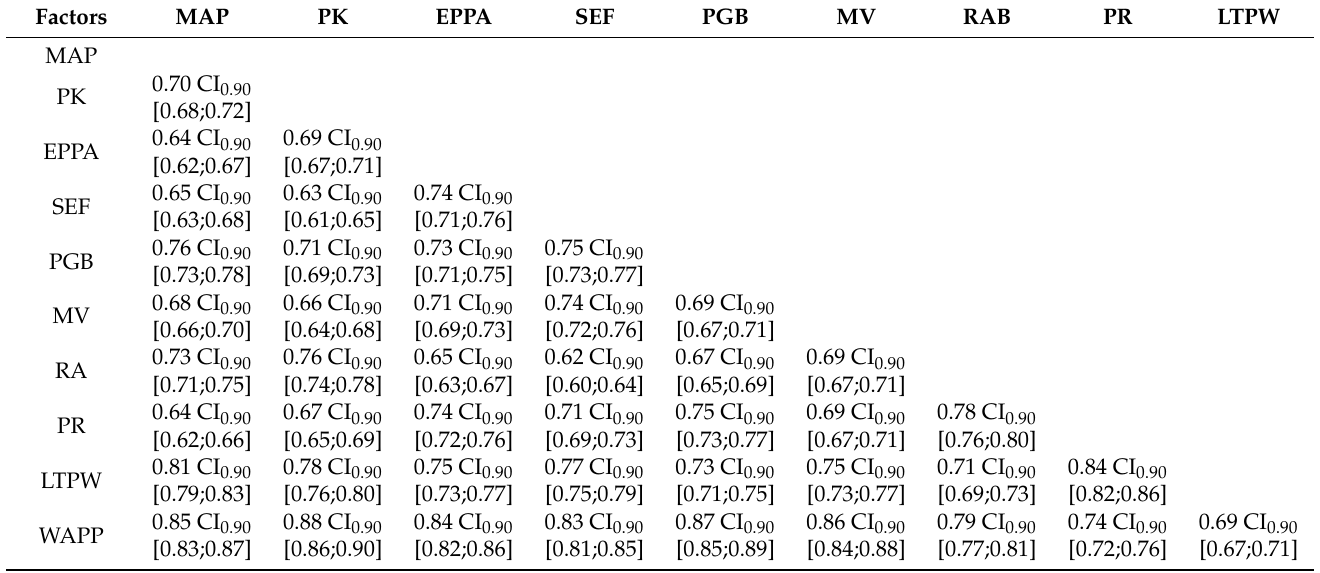
Table 4. Discriminant validity testing based on the Heterotrait-Monotrait Ratio.